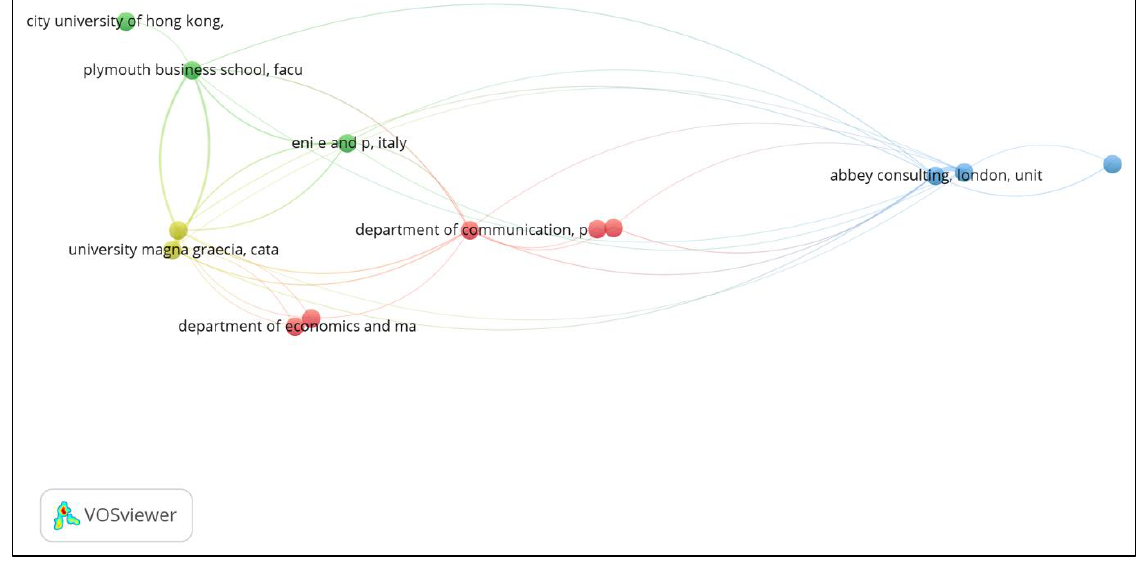
Figure 7. Organization-wise published reputation risk papers